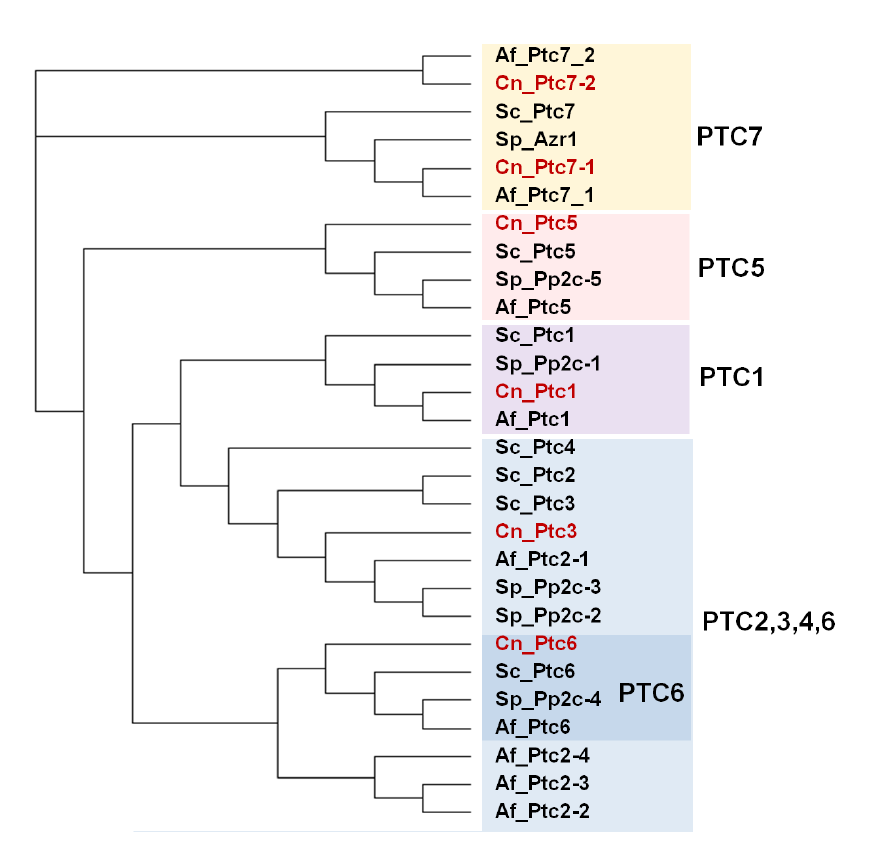
FIGURE 13: Phylogenetic relation- ships among PP2C phosphatases from various fungal species. Pro- tein sequences correspond to or- ganisms described in Figure 2. The analysis was performed as de- scribed in Figure